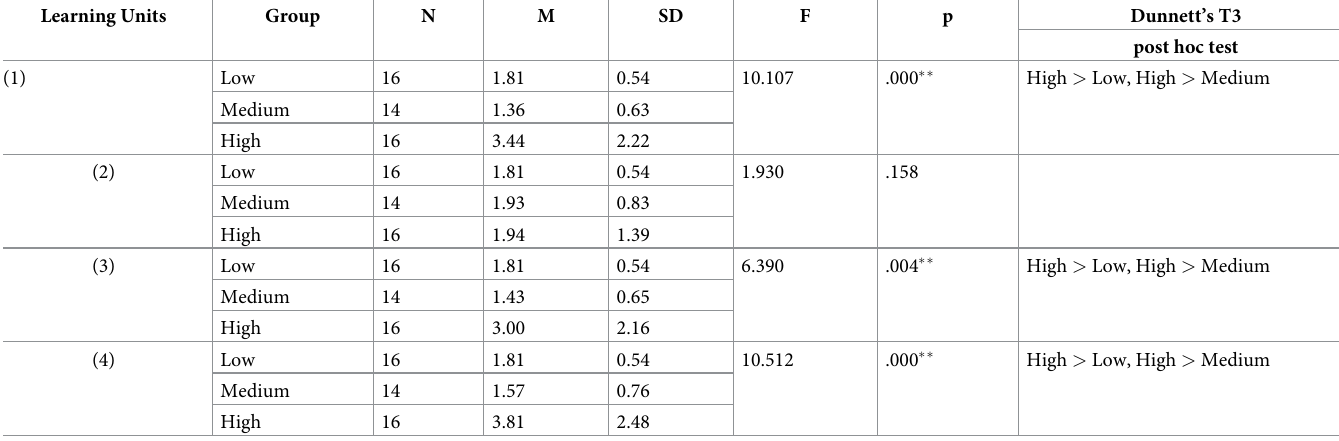
Table 7. Frequencies of visiting different learning units across